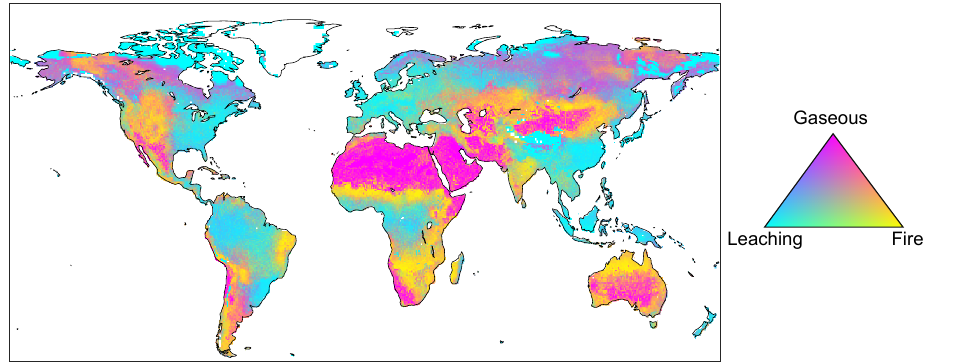
Figure 3. Relative contribution of leaching, gaseous loss, and fire to overall ecosystem N loss for the true historical simulation ( + Ndep + clim + CO 2 ) averaged over the period 1997–2006. The colours at the three corners of the triangle indicate 100% N loss by the corresponding process.